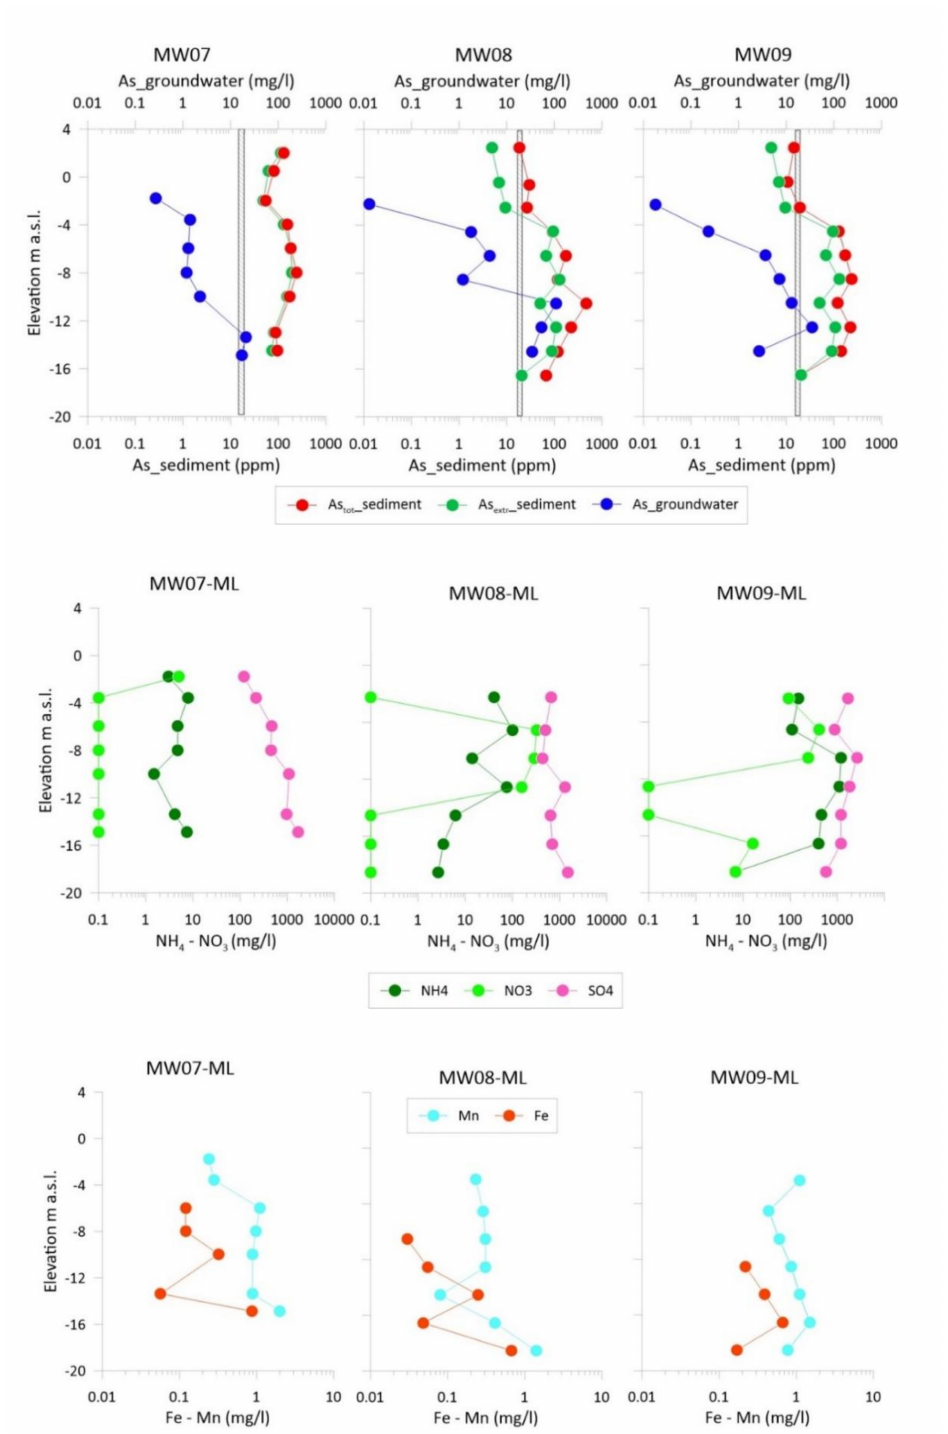
Figure 4. Total As concentration in sediments (red dots), extractable As (green dots) and in groundwater (blue dots) vertical profile in MW07-MW07-ML, MW08-MW08-ML and MW09-MW09-ML (upper panel); dashed area represents the estimate of background As concentration in sediments (Manno et al., 2007). Ammonium (NH 4 + ), Nitrate (NO 3 − , Sulfate (SO 4 2 − ) concentration vertical profiles in groundwater in MW07-ML, MW08-ML, nd MW09-ML (middle panel); Iron (Fe) and Manganese (Mn) concentration vertical profiles in groundwater in MW07-ML (left panel), MW08-ML (middle panel), and